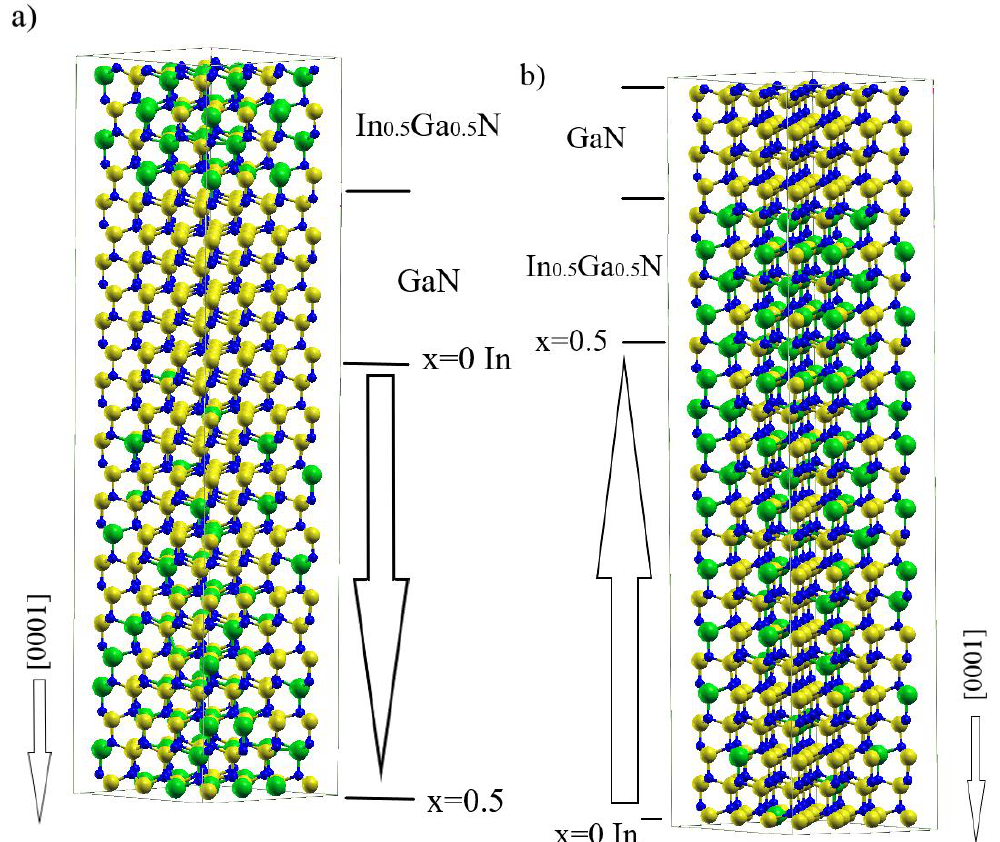
Figure 1. ( a ) In x Ga 1 − x N/GaN/In 0.5 Ga 0.5 N and ( b ) In x Ga 1 − x N/In 0.5 Ga 0.5 N/GaN supercells that were subject to ab initio calculations. The Ga x In 1 − x N layer is graded linearly, with ( a ) increasing and ( b ) decreasing In concentration towards the bottom of the ([0001] direction). Ga, In and N atoms are represented by yellow, green and blue balls,